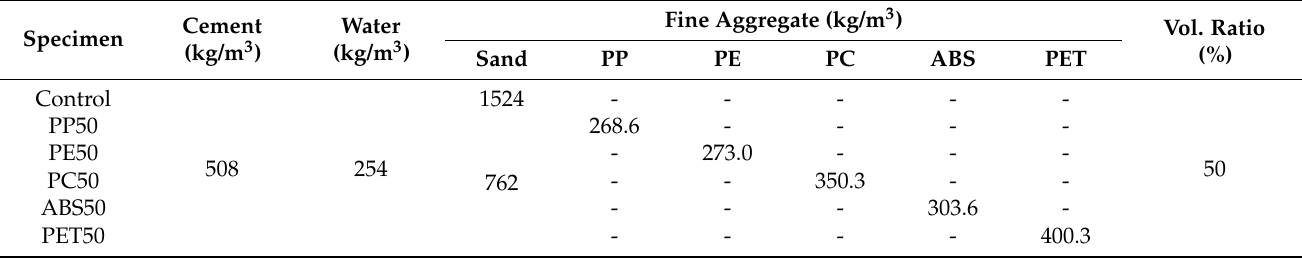
Table 5. Mix design of cementitious